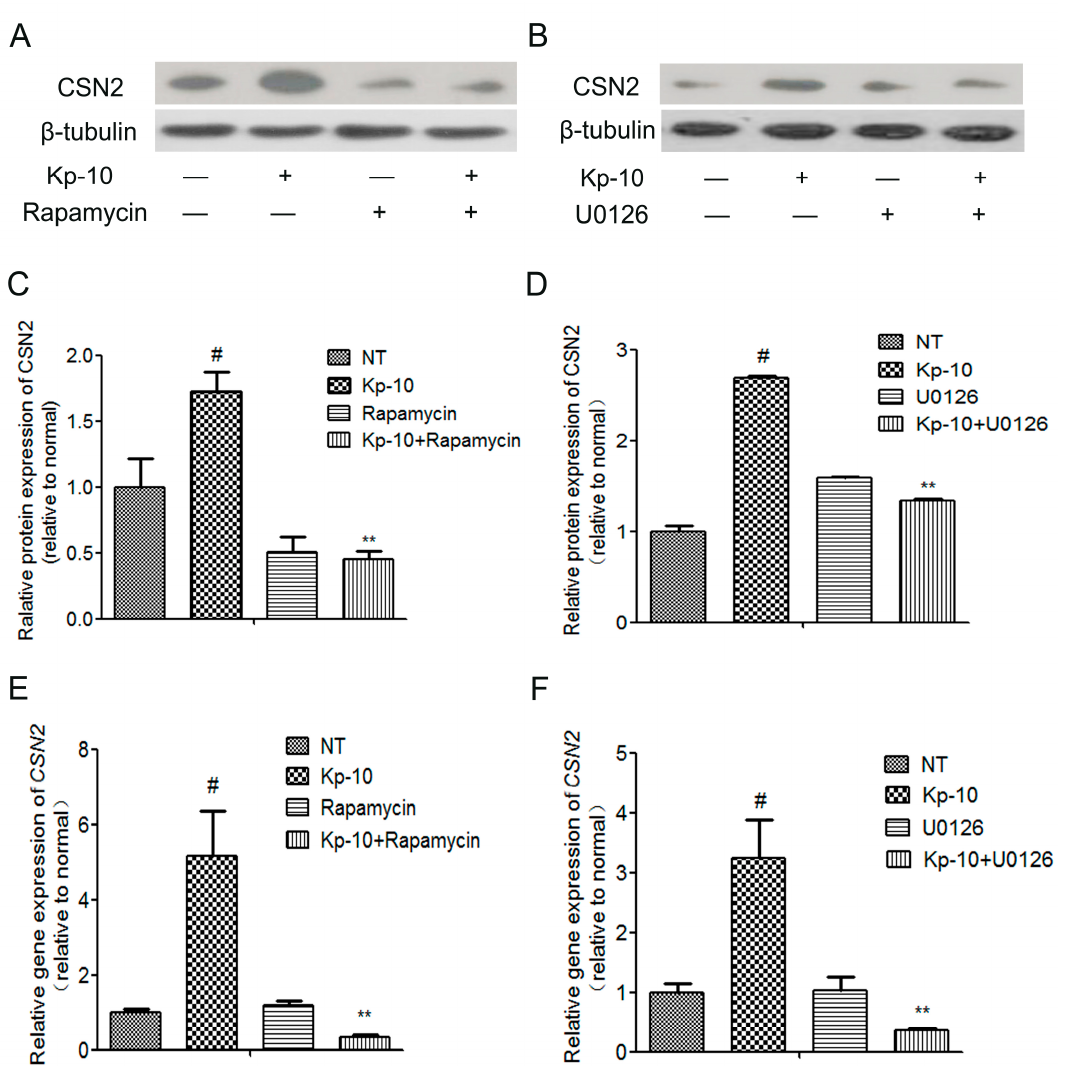
Figure 6. The mTOR inhibitor Rapamycin and the ERK1/2 inhibitor U0126 attenuated the Kp-10-induced the increased gene and protein expression of CSN2 in bMECs. The cells were pre-treated for 1 h with Rapamycin (200 nM) or U0126 (10 µ M) and then incubated for 12 h with Kp-10 (100 nM). The protein ( A – D ) and gene ( E , F ) expression of CSN2 was examined by Western blot and quantitative real-time PCR. The data is presented as the means ± S.D. ( n = 3; # p < 0.01 vs. NT; ** p < 0.01 vs. Kp-10 treatment).